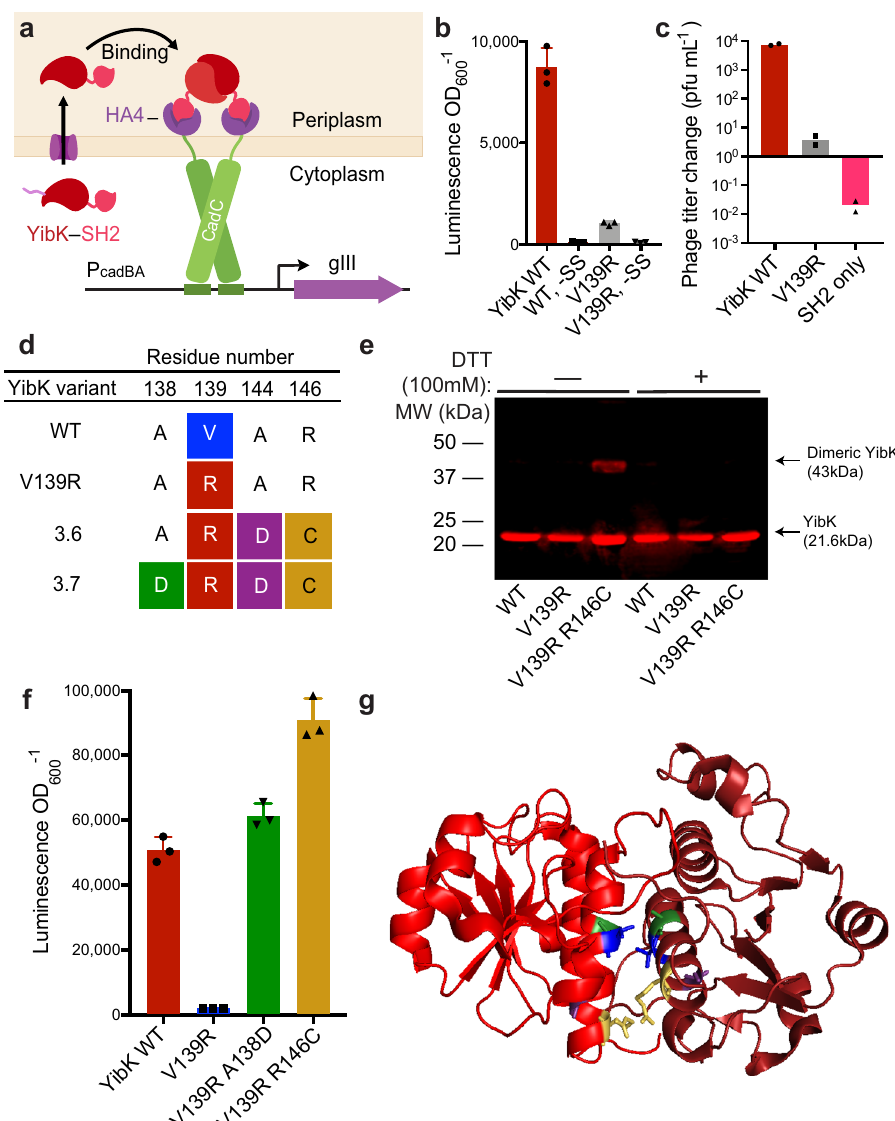
Fig. 2 Periplasmic phage-assisted non-continuous evolution of the dimeric knottin YibK rescues binding mutants and evolves new disul fi de bonds. a Schematic of homodimeric YibK selection. HA4 monobody (purple) recruits SH2 (pink) to CadC, and CadC monomers (green) are brought together by homodimerization of YibK (red). b Transcriptional activation assay comparing the performance of wild-type YibK − SH2 construct (WT) to the V139R binding mutant in the presence and absence of a signal sequence (SS) to direct periplasmic export. The architecture of the luciferase-based transcriptional reporter is shown in Supplementary Fig. 2a. Bar values and error bars represent the mean and s.d. of three independent biological replicates. c Phage propagation assay. Mid-log-phase cultures of selection strains were inoculated with phage and allowed to propagate overnight before determining titer. WT SS − YibK − SH2 phage enriches robustly, while the YibK V139R point mutant in the same construct enriches weakly and phage encoding only SP − SH2 fail to enrich. Bar values represent the mean of two independent biological replicate experiments carried out on separate days. ( d ) PANCE of YibK variant V139R evolves variants 3.6 and 3.7, showing two compensatory point mutations, A138D and R146C. R146C establishes a novel intermolecular disul fi